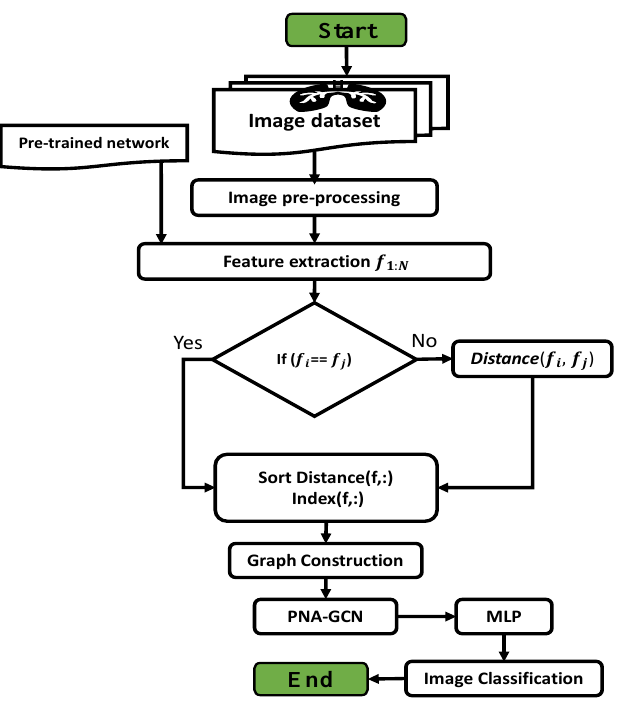
Figure 3. The methodology flowchart.